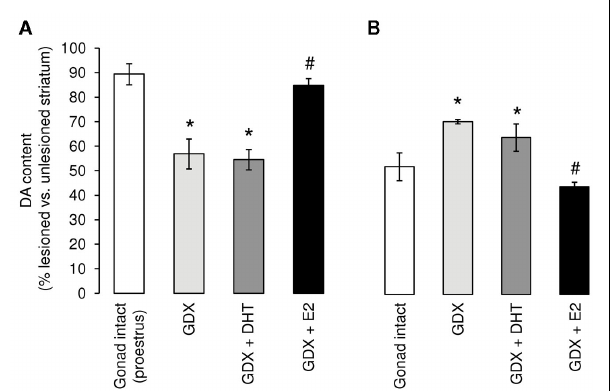
Figure 2 control, gonad-intact groups; Murray et al., 2003; Gillies et al., 2004). Moreover, the progressive loss of dopaminergic cells over a 5-week period post-lesioning was consistently greater in 6- OHDA-treated male rats, confirming a true sex difference rather a difference in the rate of neurodegeneration (Moroz et al., 2003).